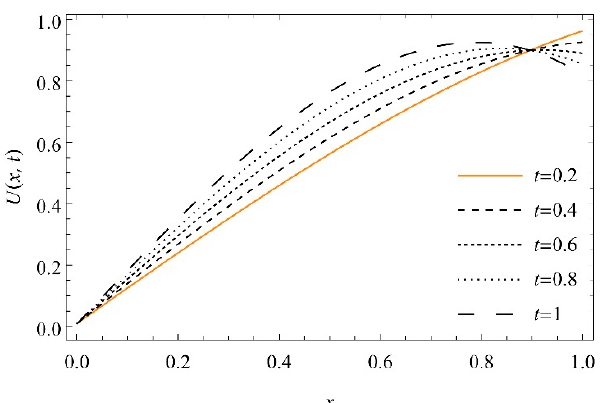
Figure 3. The graph of 𝑈(𝑥,𝑡) versus depth 𝑥 𝑛 = 1, 𝛼 = 1 , and for 𝑡 = 0.2, 0.4, 0.6,0.8, 1 for Equa- tion (29).